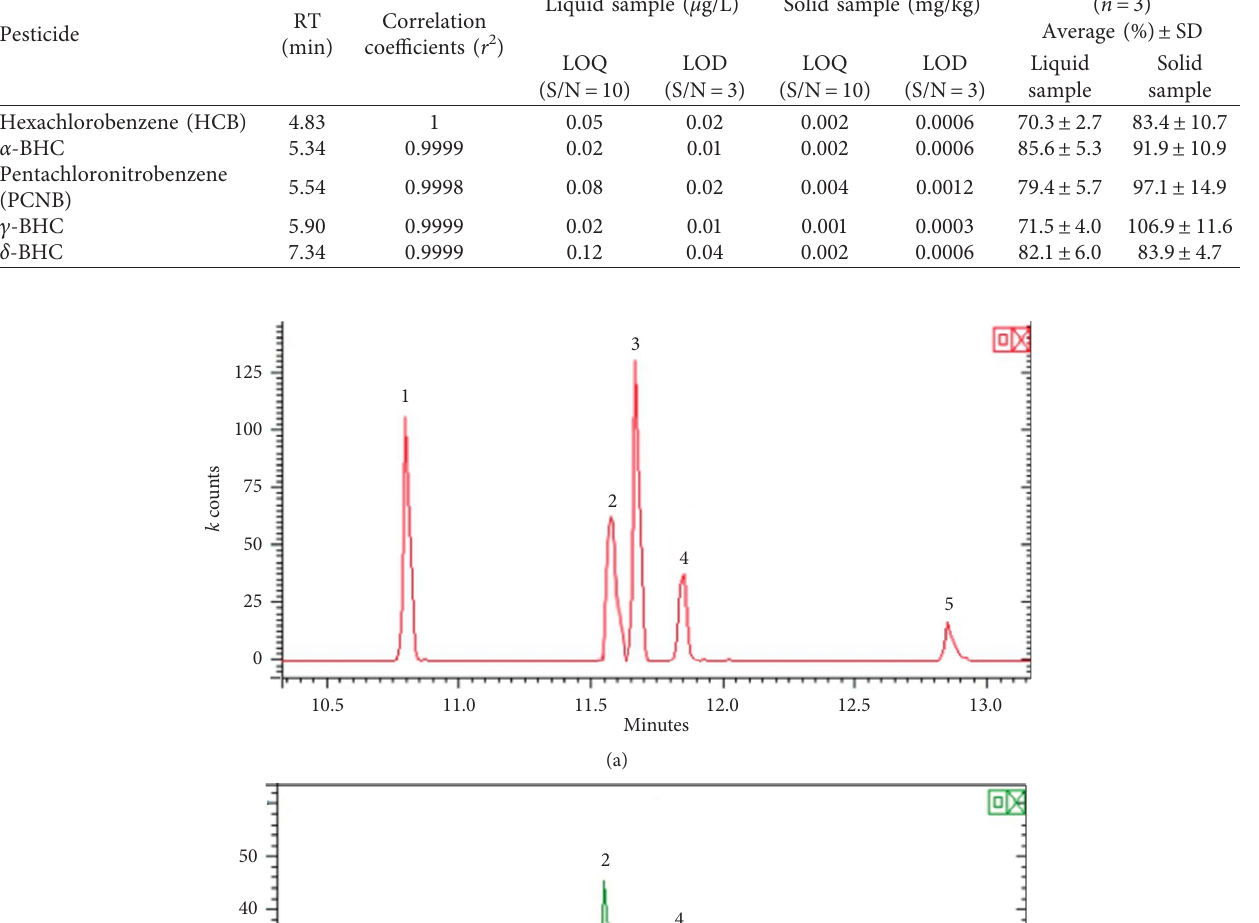
Table 2: Results of the method validation study, including retention time, correlation coefficients, LOQs, and recoveries. RT Pesticide